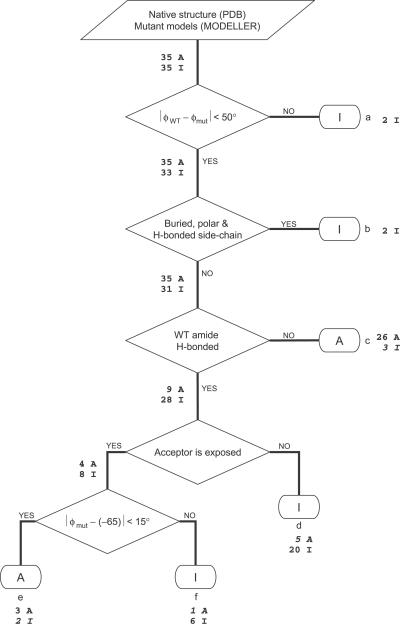
Model Decision TreeThe flowchart of scheme for prediction of effects of Pro mutations on protein stability derived from structural analysis of WT crystal structure and mutant models. A and I refer to active and inactive predictions, respectively. Letters in lowercase (a–f) refer to each node of the scheme as described in the text. Numbers at each branch indicate the number of active and inactive mutants satisfying the “Yes” or “No” criteria of the respective branch. The numbers at each A and I prediction bubble correspond to the number of CcdB Pro mutants ending at that bubble. The numbers of misclassified mutants are shown in italics. Active mutants correspond to nonperturbing Pro substitutions and inactive ones to perturbing Pro substitutions in case of CcdB.